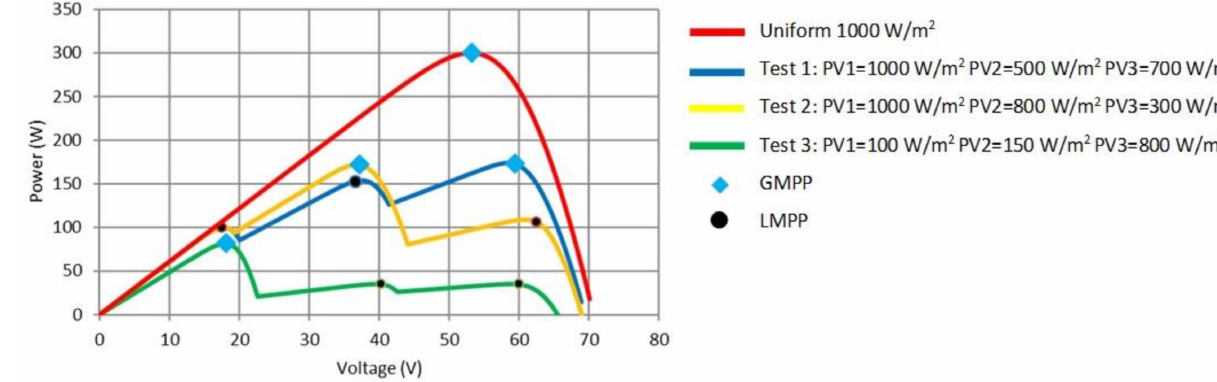
Figure 4. Power-Voltage characteristics of PV under